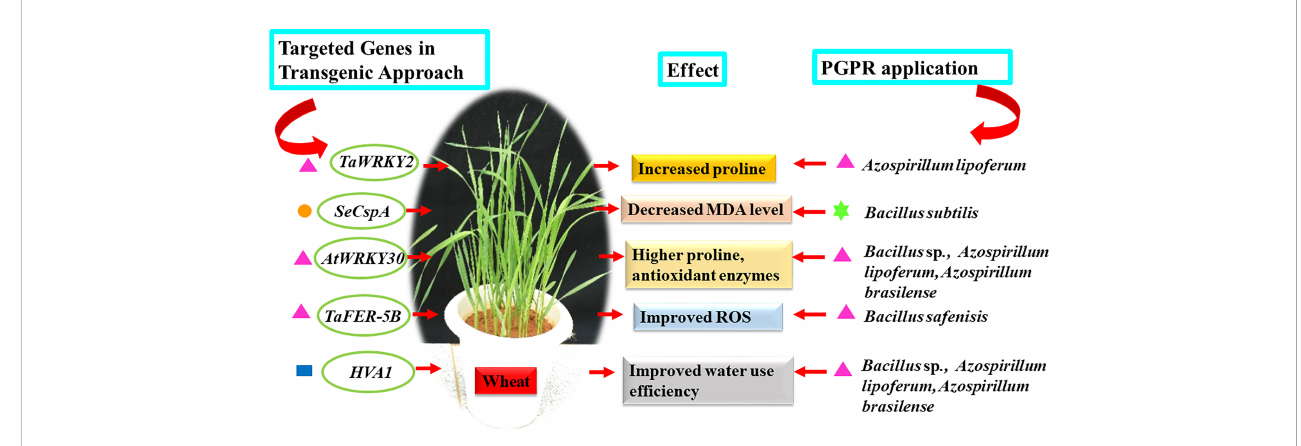
FIGURE 2 Model representing common physiological responses observed in wheat crop via transgenic approach and PGPRs application. Different colored symbols in the fi gure indicates the conditions of the experiment ( Pots, Filter Paper, Hydroponics, Greenhouse potting